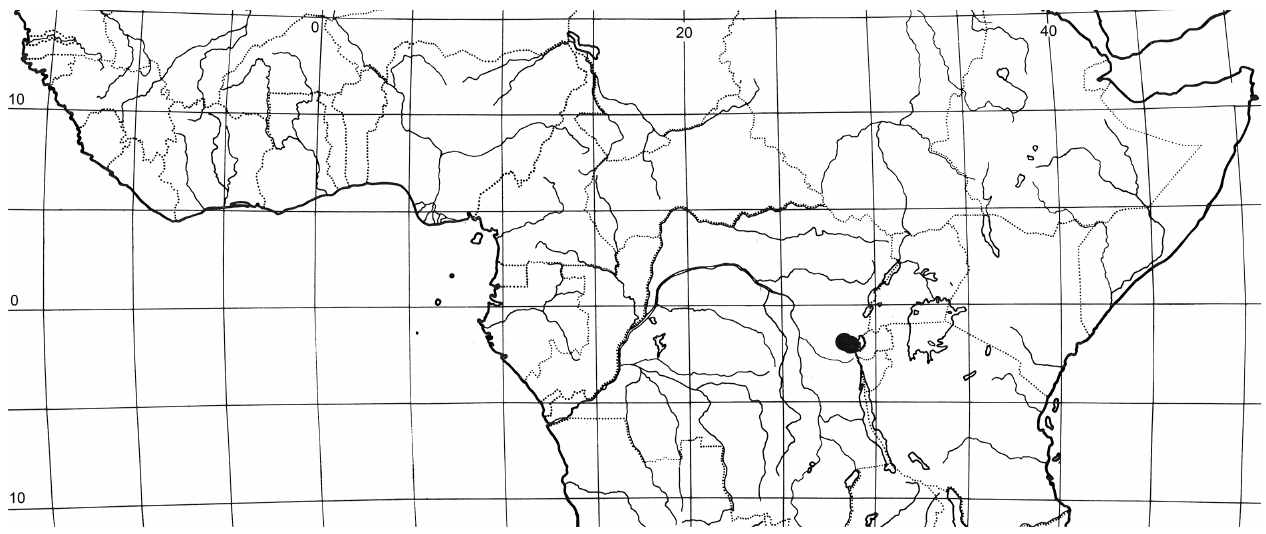
Figure 2 – Distribution map of Ixora kalehensis (adapted from De Block